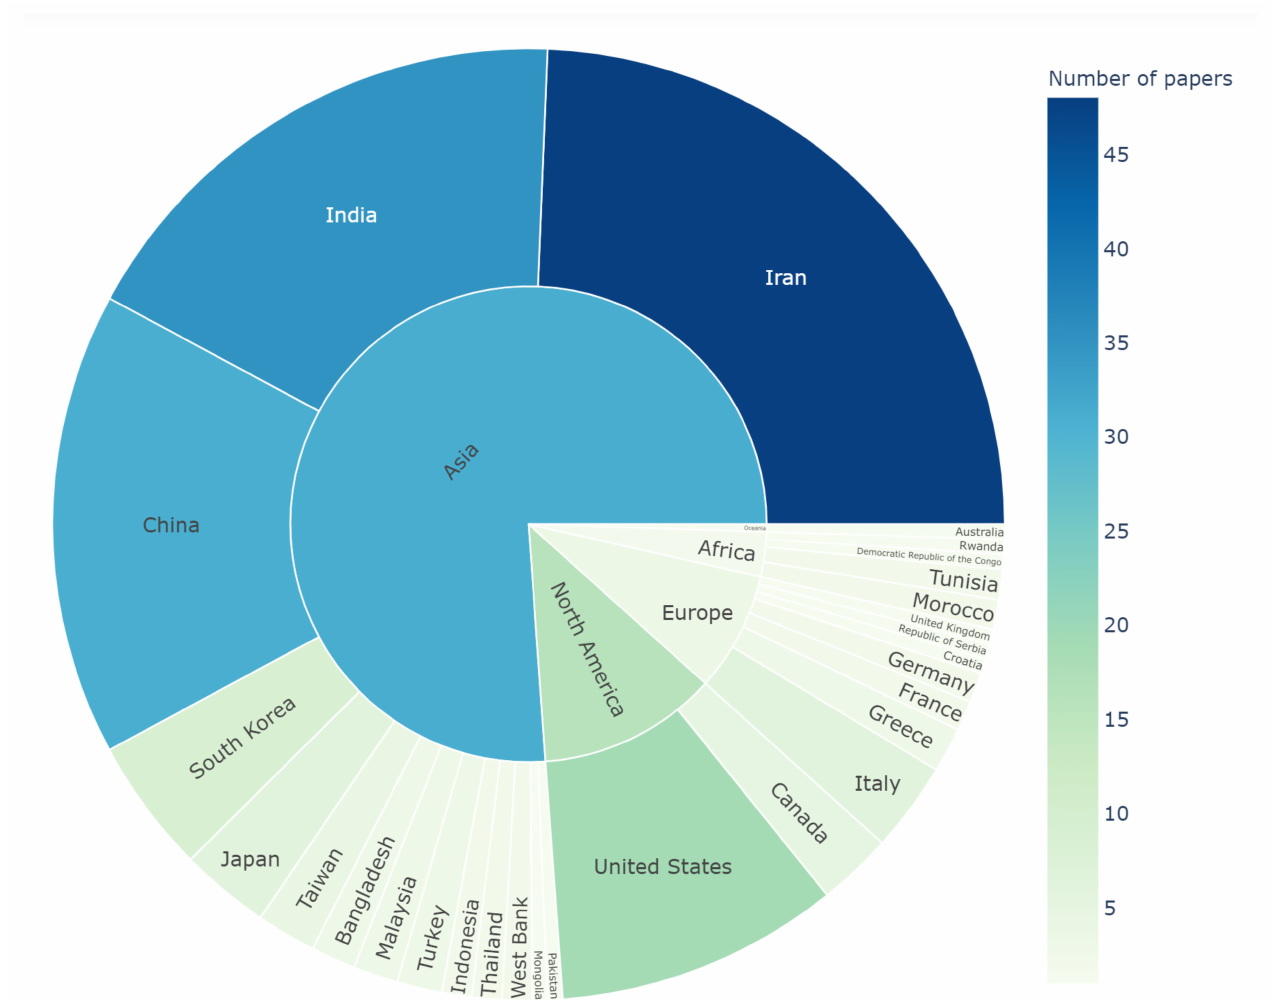
Figure 3. Pie chart of the included research articles based on the country of